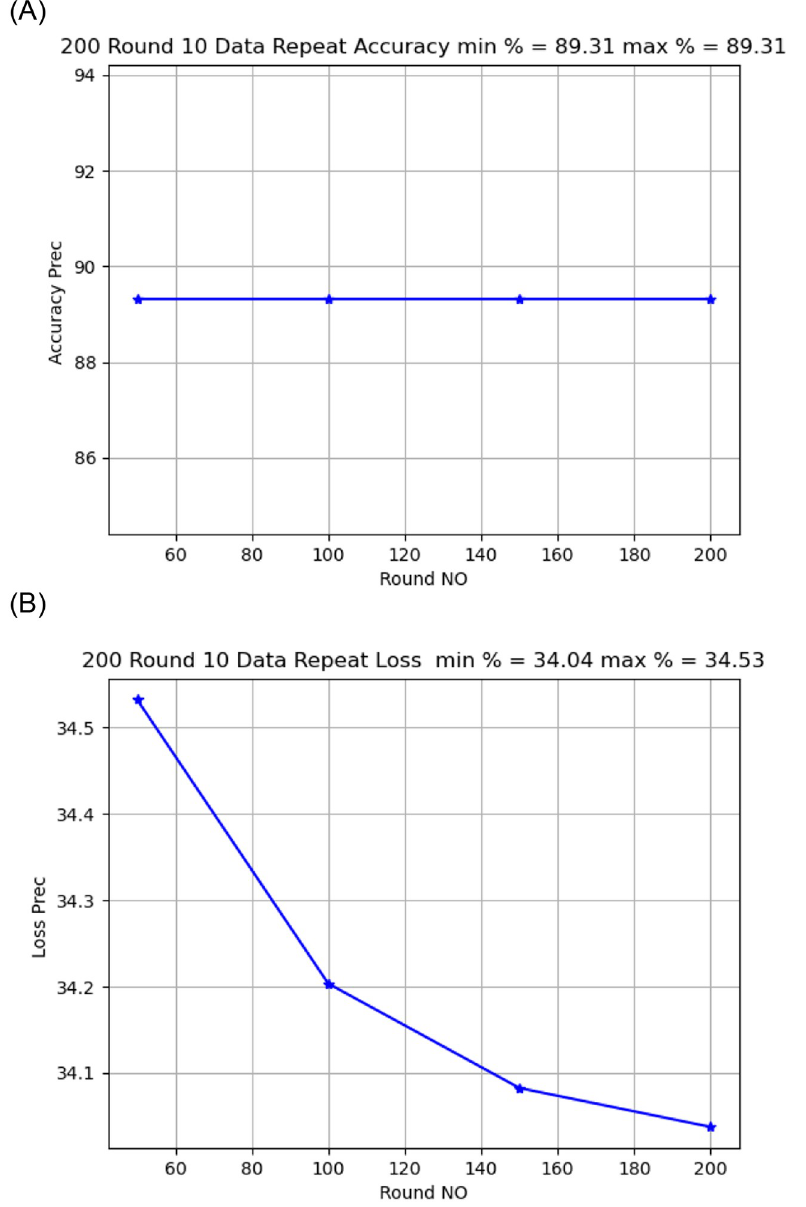
Fig 10. Learning rate